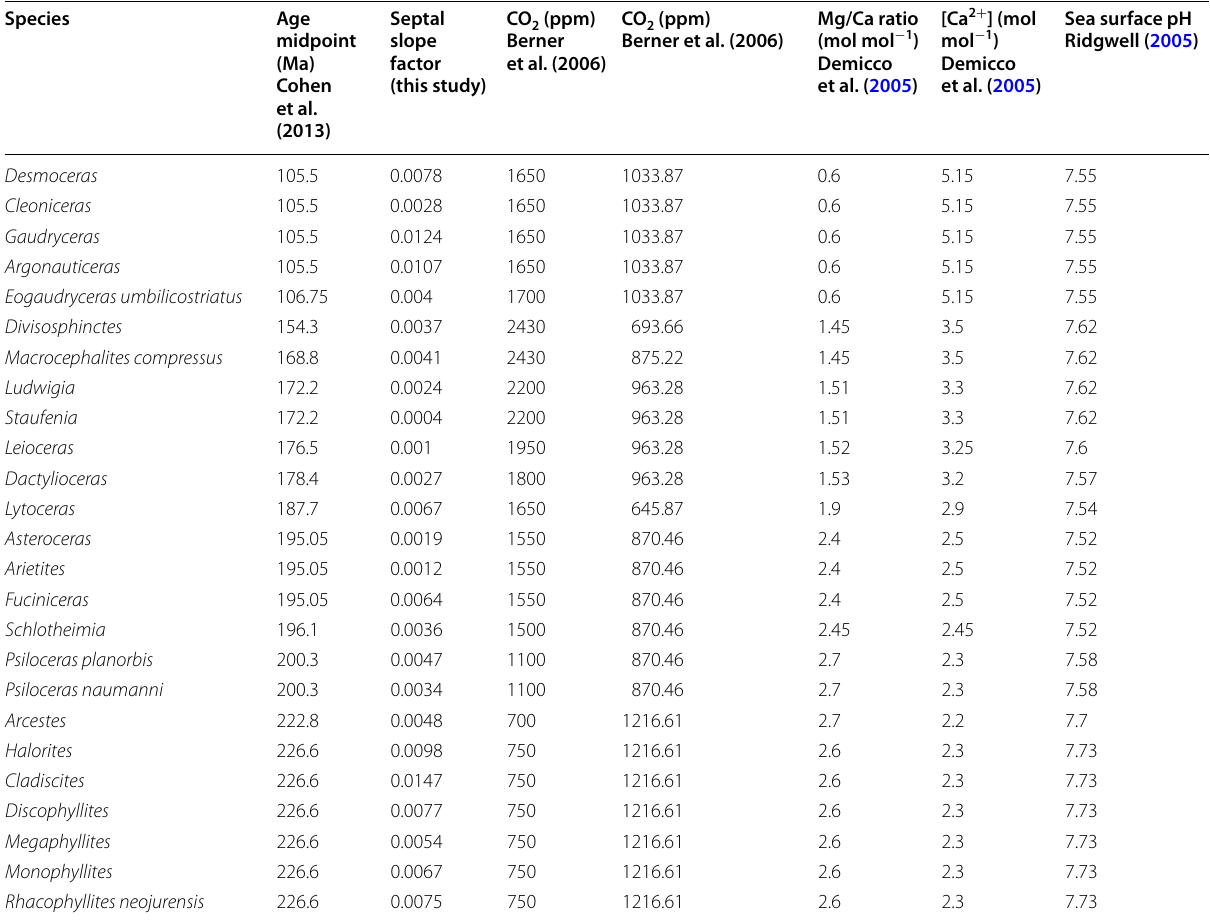
Table 7 States of four abiotic factors correlated with age midpoint (average of ages of the beginning and the end of the corresponding stages after international chronostratigraphic chart from stratigraphy.org) and septal slope factor of ontogenetic trajectory of septal thickness through the Mesozoic. Palaeoenvironmental data are from Berner (2006): CO Ca ratio, [Ca 2 + ] (mol mol − 1 ), and Ridgwell (2005): Sea surface